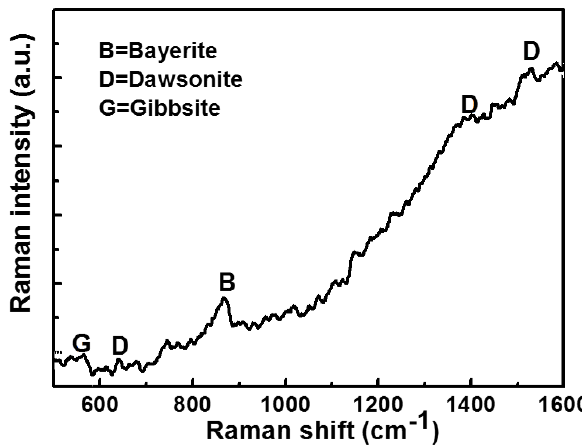
Figure 11. Raman spectroscopy of passive film formed on Al coating after 384 h of exposure in SAE J2334 solution.